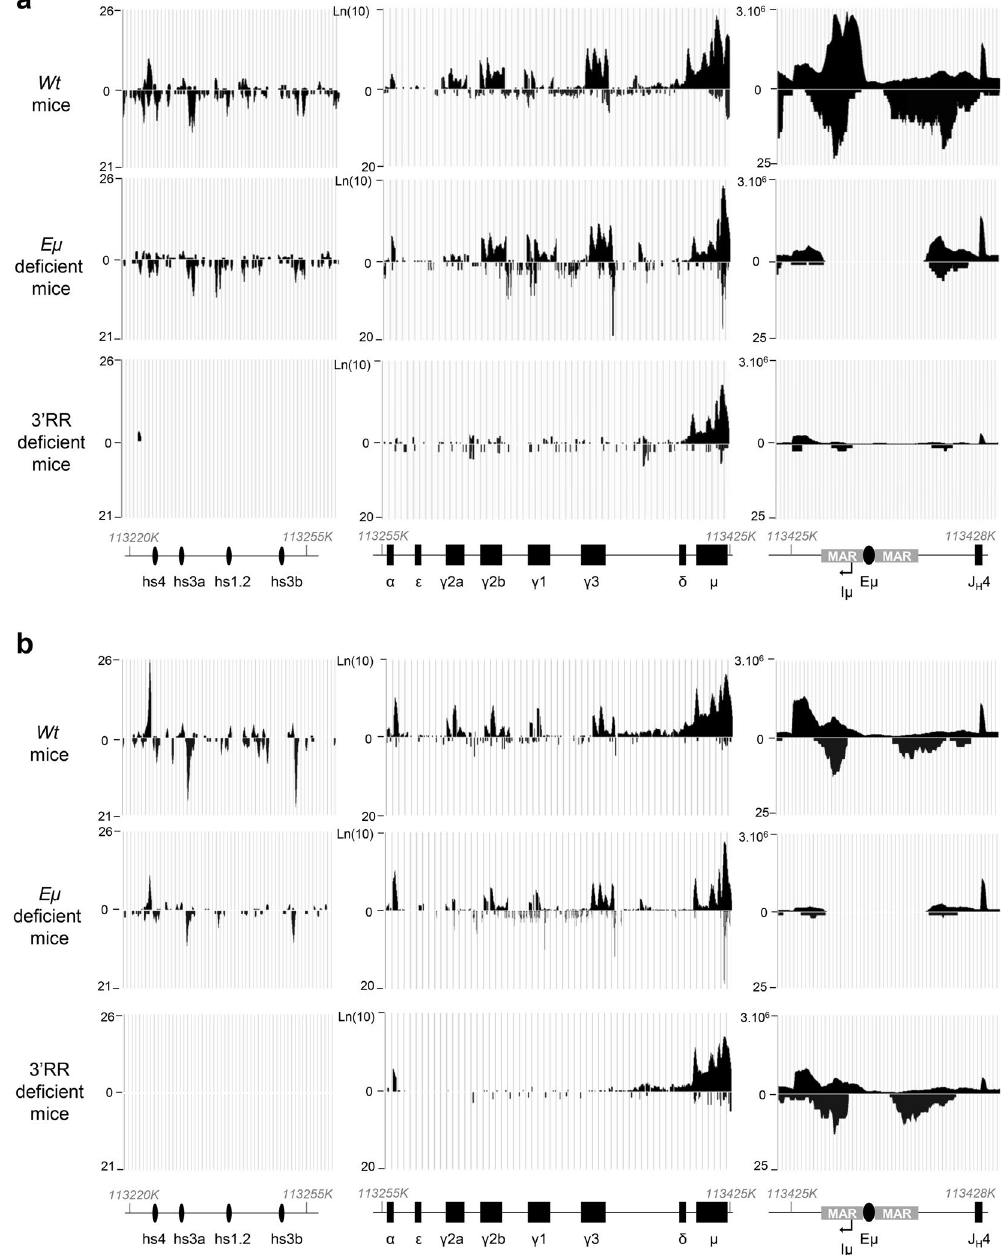
Figure 3. Influence of E μ and 3 ′ RR on IgH transcription during CSR. ( a ) IgH transcription on LPS-stimulated B-cells of wt , E μ -deficient and 3 ′ RR-deficient mice. CD43-depleted splenocytes were cultured for 2 days with 5 μ g LPS. RNAseq experiments were done after depletion of rRNA. Data are the mean of two independent experiments with 3 mice per genotype. ( b ) IgH transcription on resting B-cells of wt , E μ -deficient and 3 ′ RR- deficient mice. RNAseq experiments were done with CD43-depleted splenocytes after depletion of rRNA. Data are the mean of two independent experiments with 3 mice per genotype. Precise locations of I μ , S μ , C μ , C δ , I γ 3 , S γ 3 , I γ 2b and S γ 2b are reported in Supplementary Figs